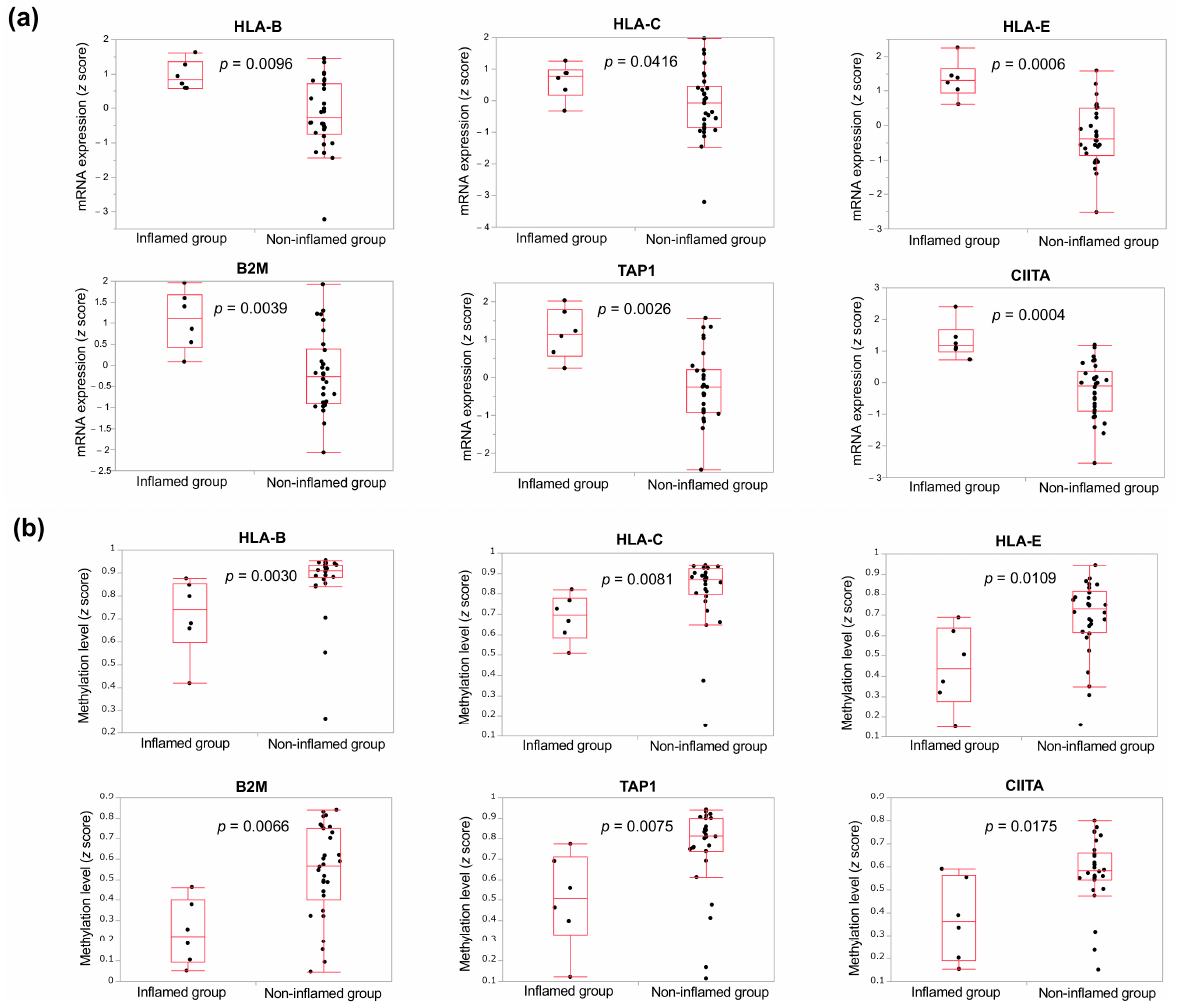
Figure 4. Comparisons of mRNA expression and DNA methylation level between inflamed and non-inflamed cholangiocarcinoma. mRNA expressions of the genes involved in antigen presentation are significantly higher in inflamed group than in non-inflamed group for all comparisons ( a ). Similarly, their DNA methylation levels are significantly lower in inflamed group than in non-inflamed group for all comparisons ( b ). Red boxes and whisker plots denote 75% and 95% distribution, respectively, and the red lines in the boxes show the median values. p values by non-parametric Wilcoxon rank-sum test are shown.